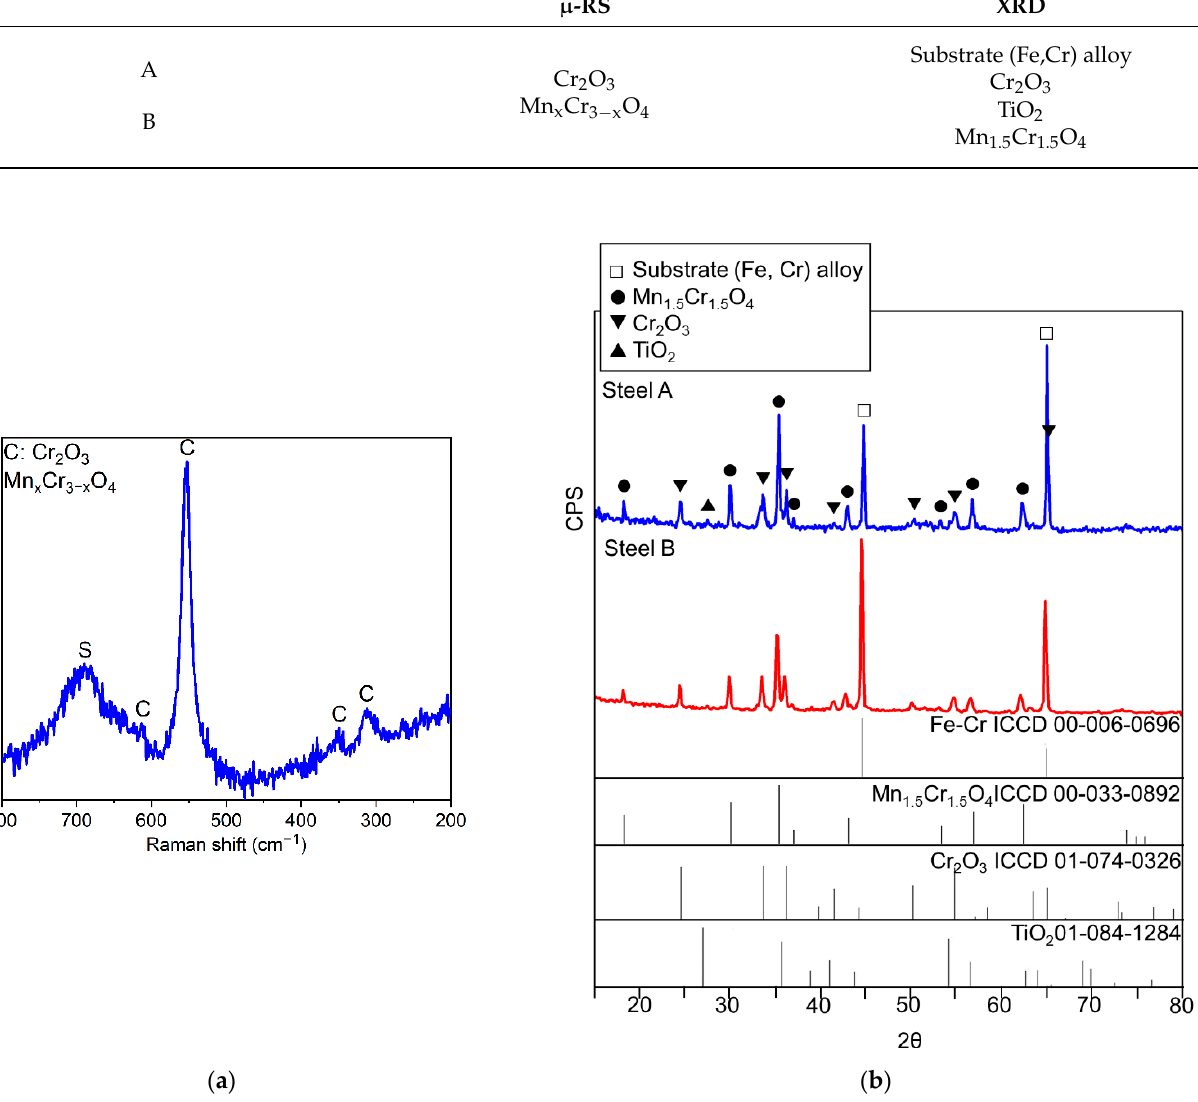
Figure 8. Experimental Raman spectrum of the oxide scale grown on Steel A with the indication of compounds identified through comparison with literature [49–51] ( a ) and experimental diffractograms, Steel A and Steel B ( b )